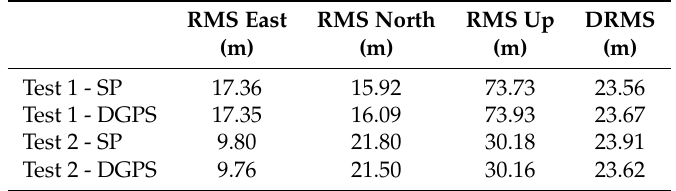
Table 3. Performance of Single-Point and Code Differential positioning for the Software-Defined